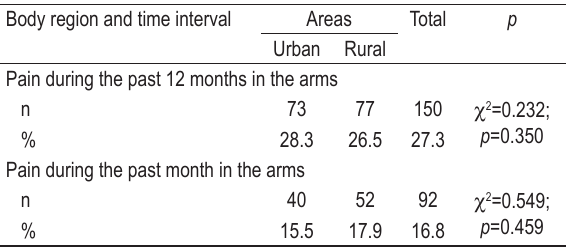
TABLE 5. The presence of pain in arms Body region and time interval Areas Total p